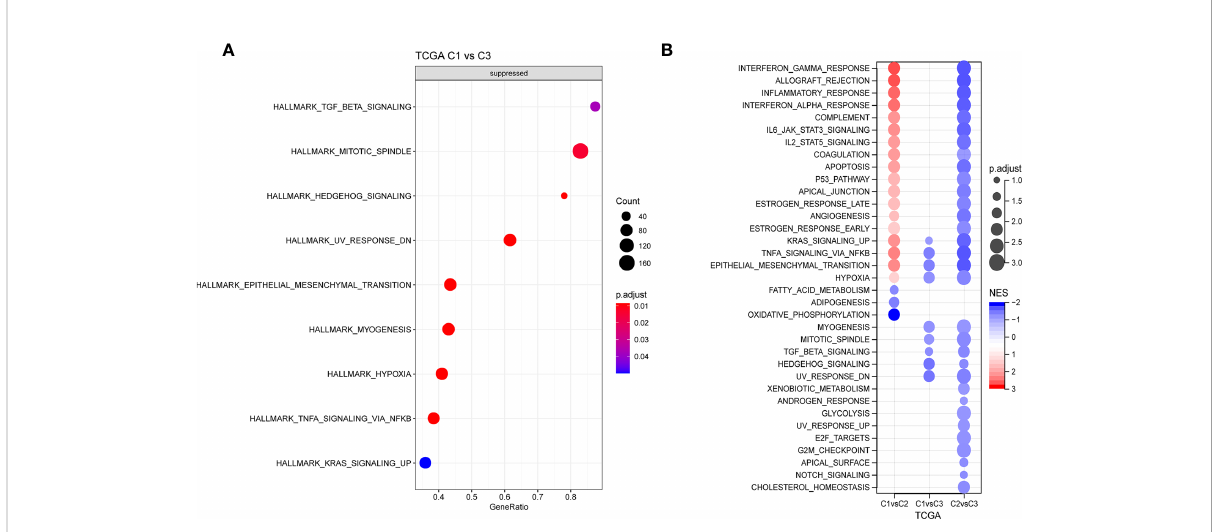
FIGURE 6 (A) GSEA of C1 vs. C3 in TCGA cohort. (B) GSEA of different molecular subtypes. GSEA, Gene Set Enrichment Analysis; TCGA, The Cancer Genome